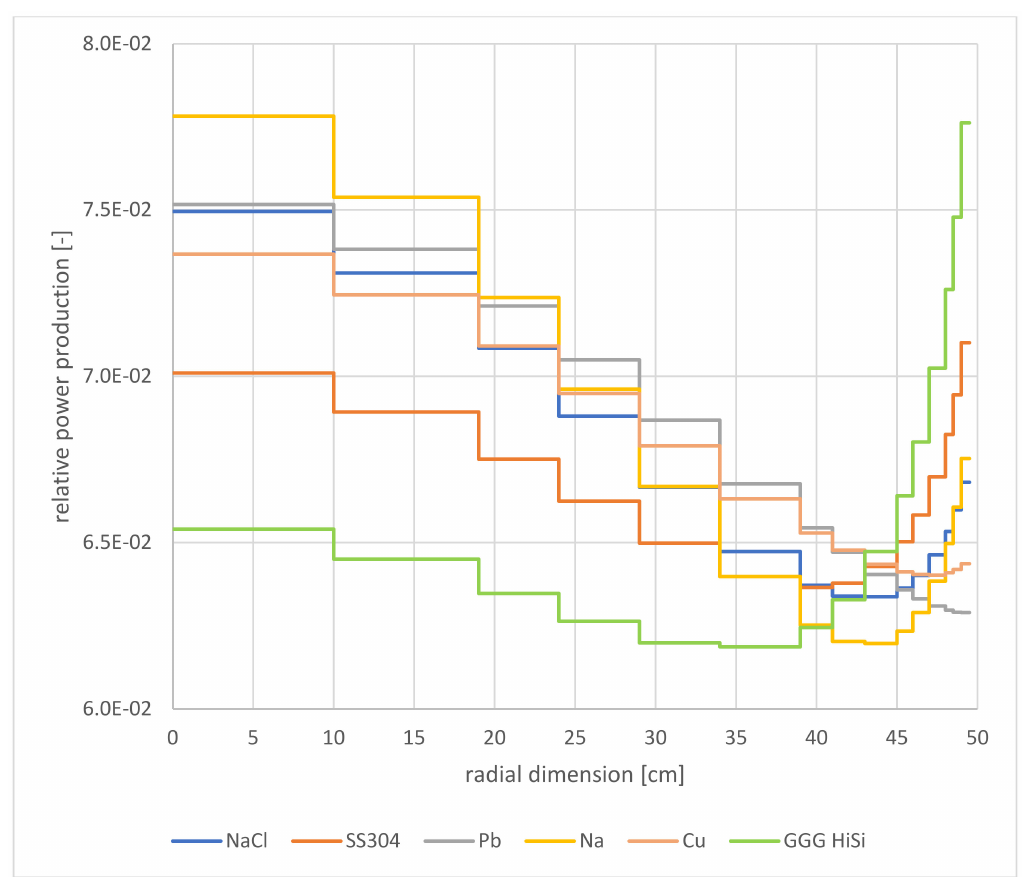
Figure 9. Narrowed-down choice of materials for a deeper investigation of the radial power distribution investigated in a 2D system for different reflector materials for a zero-power experimental